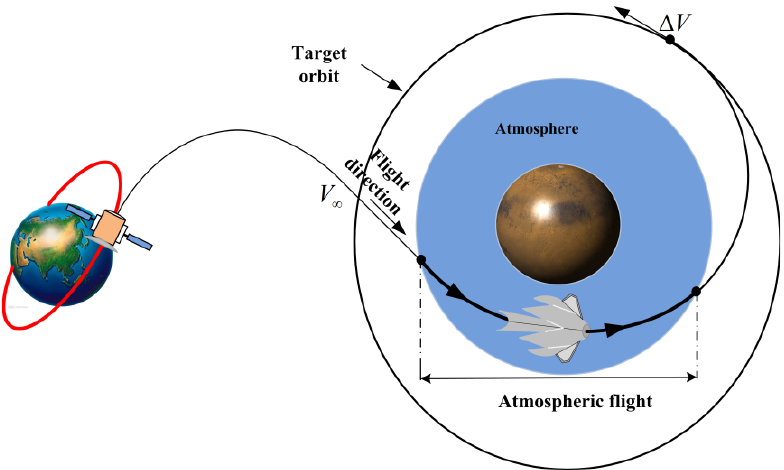
Figure 1. Schematic diagram of the Mars aerocapture process.